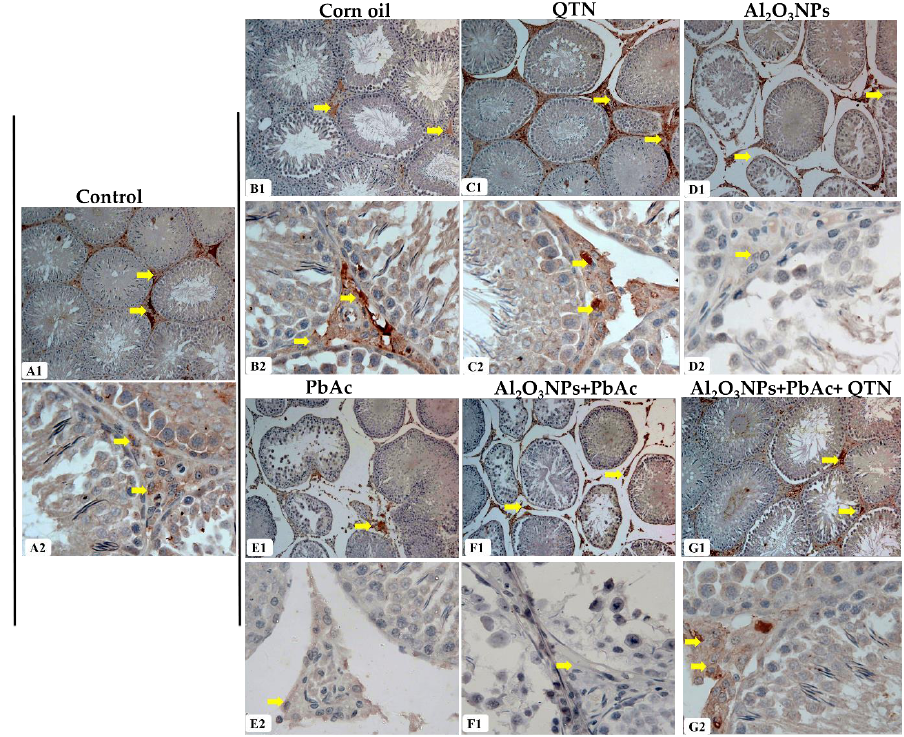
Figure 5. ( A1 , A2 ) Testis of the control group showing strong interstitial cell staining for androgen receptors and lack of immuno-reaction in seminiferous tubules. ( B1 , B2 ) Testis of corn oil-treated group showing normal immuno-expression in the interstitial cells. ( C1 , C2 ) Testis of QTN-treated group showing normal expression of immuno-staining of interstitial cells. ( D1 , D2 ) Testis of Al 2 O 3 NPs-exposed group showing moderate immuno-expression of the androgen receptor. ( E1 , E2 ) Testis of PbAc-exposed group showing weak androgen receptor expression. ( F1 , F2 ) Testis of Al 2 O 3 NPs and PbAc co-exposed group showing weak androgen receptor expression. ( G1 , G2 ) Testis of Al 2 O 3 NPs and PbAc co-exposed and QTN-treated group showing strong androgen receptor ex- pression in the interstitial cells (Androgen receptor immunostain, ×100 for A1-G1 and ×400 A2 – G2).